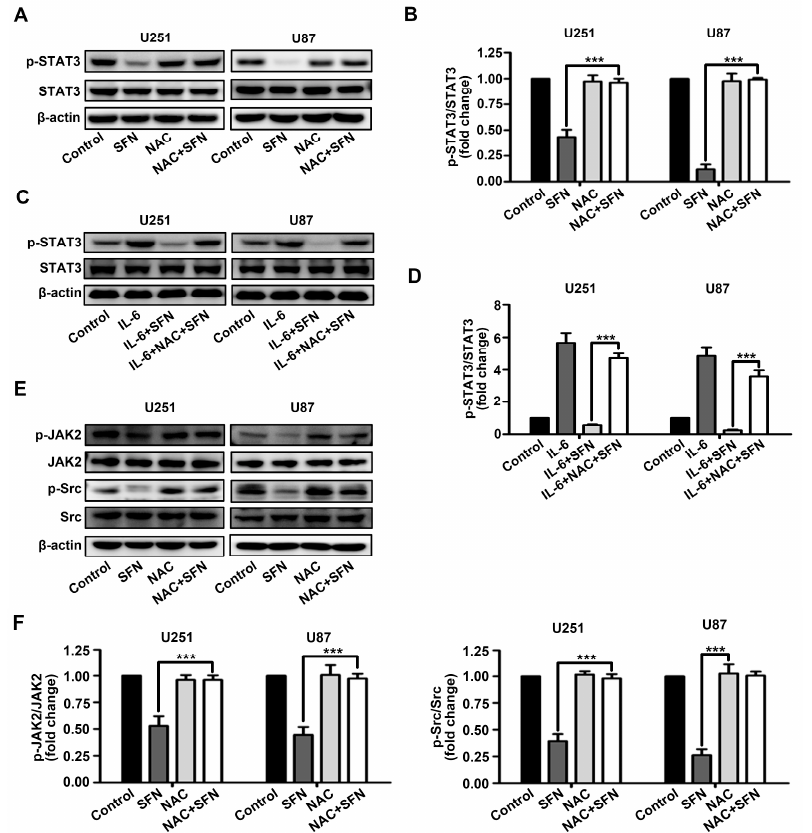
Figure 6. SFN-induced inactivation of STAT3 signaling in GBM cells is dependent on intracellular ROS generation. ( A , B ) Cells were treated with SFN (40 µM) for 24 h in absence or presence of NAC. Cell lysates were subjected to western blot to analyze the expression of phospho-STAT3 and STAT3; ( C , D ) cells were pre-incubated with or without NAC (3 mM), then add IL-6 (50 ng/mL) combined with SFN or DMSO. Cell lysates were subjected to Western blot to analyze the expression of phosphor-STAT3 and STAT3; and ( E , F ) cells were treated with SFN (40 µM) for 24 h after pre-incubation with or without NAC (3 mM). Cell lysates were subjected to Western blot to analyze the expression of phospho-JAK2, JAK2, phospho-Src, and Src. The bands corresponding to each proteins were quantified and normalized relative to band intensities for control group. Data are represented as means ± SD. *** p < 0.001 versus only SFN or SFN + IL-6 group.